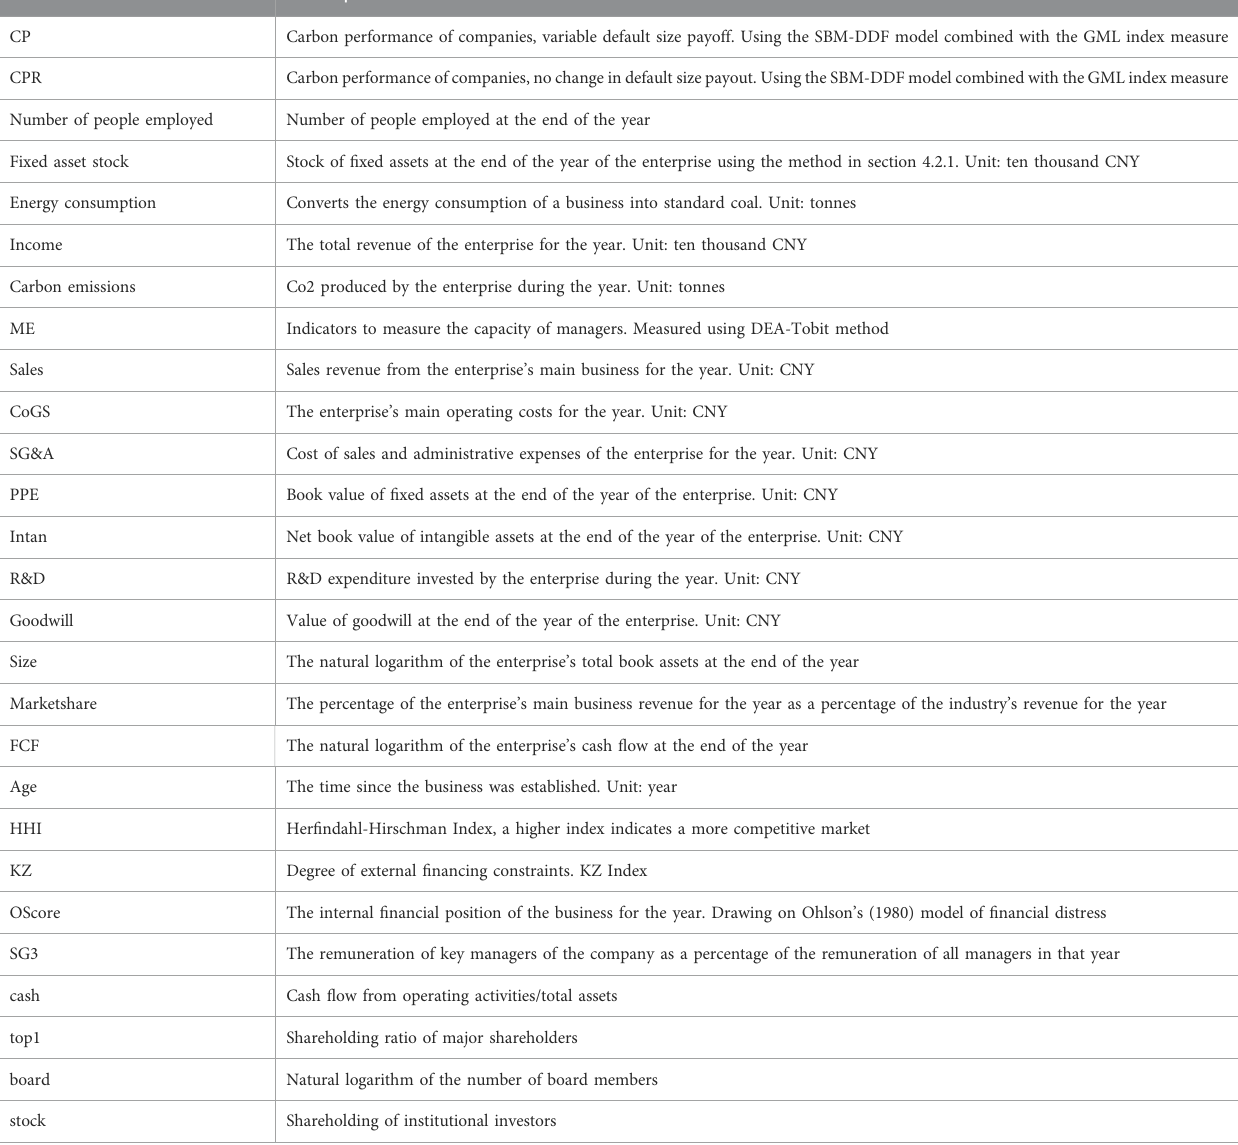
TABLE A1 Variable de fi